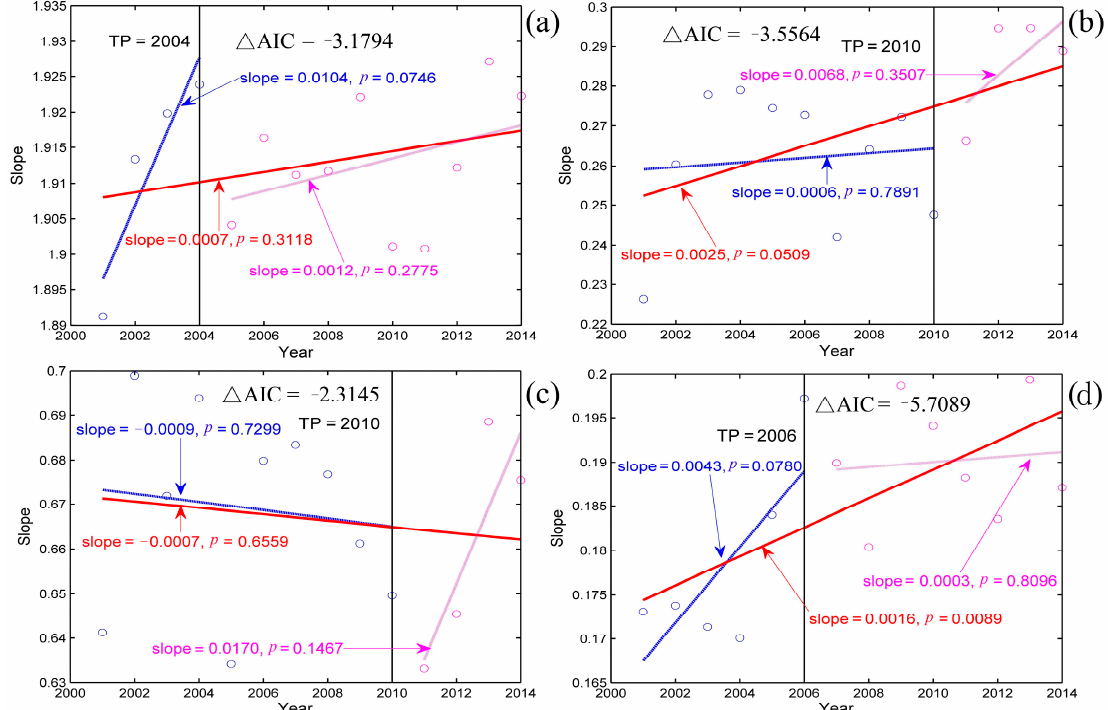
Figure 5. Inter-annual variations of Net Primary Productivity (NPP) in China at national level ( a ) and regional level (Northern China ( b ); Southern China ( c ); and the Tibetan Plateau ( d )). Trends estimated by the least-squares linear regression are shown. The blue and pink lines indicate the linear fit before and after the turning year, respectively. The red line indicates linear fit during the period 2001–2014. TP represents the turning point year.